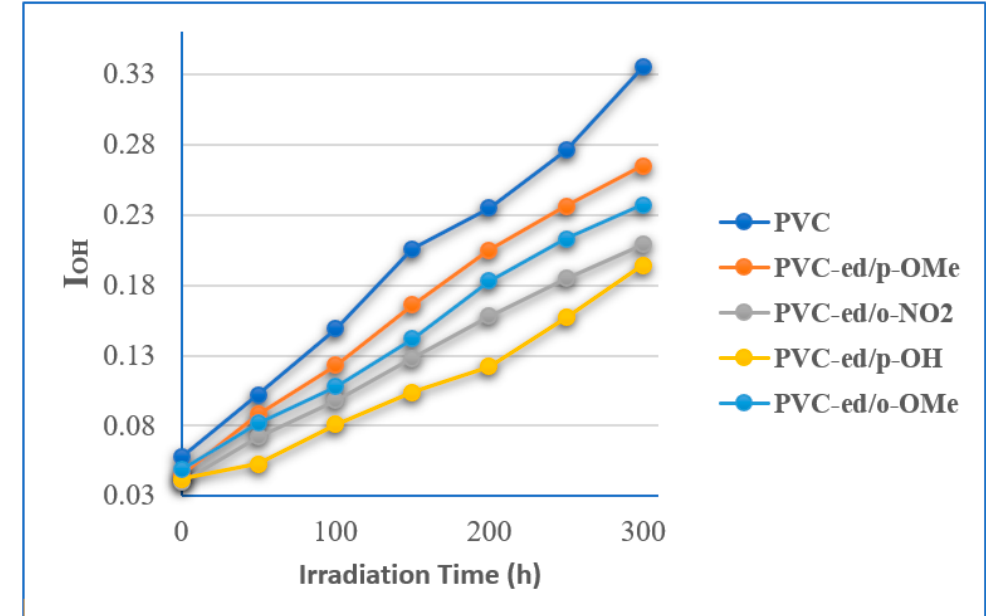
Figure 6. Hydroxyl group index against irradiation time for prepared polymeric films.